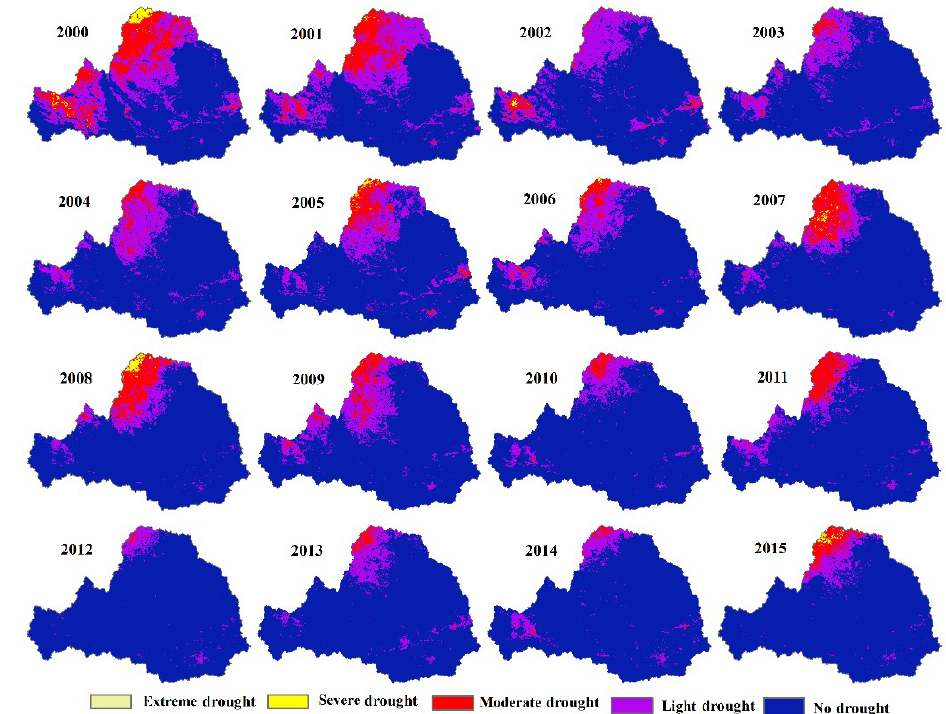
Figure 9. Spatial distributions of drought from 2000 to 2015 based on the VHI in the Wei River Basin.